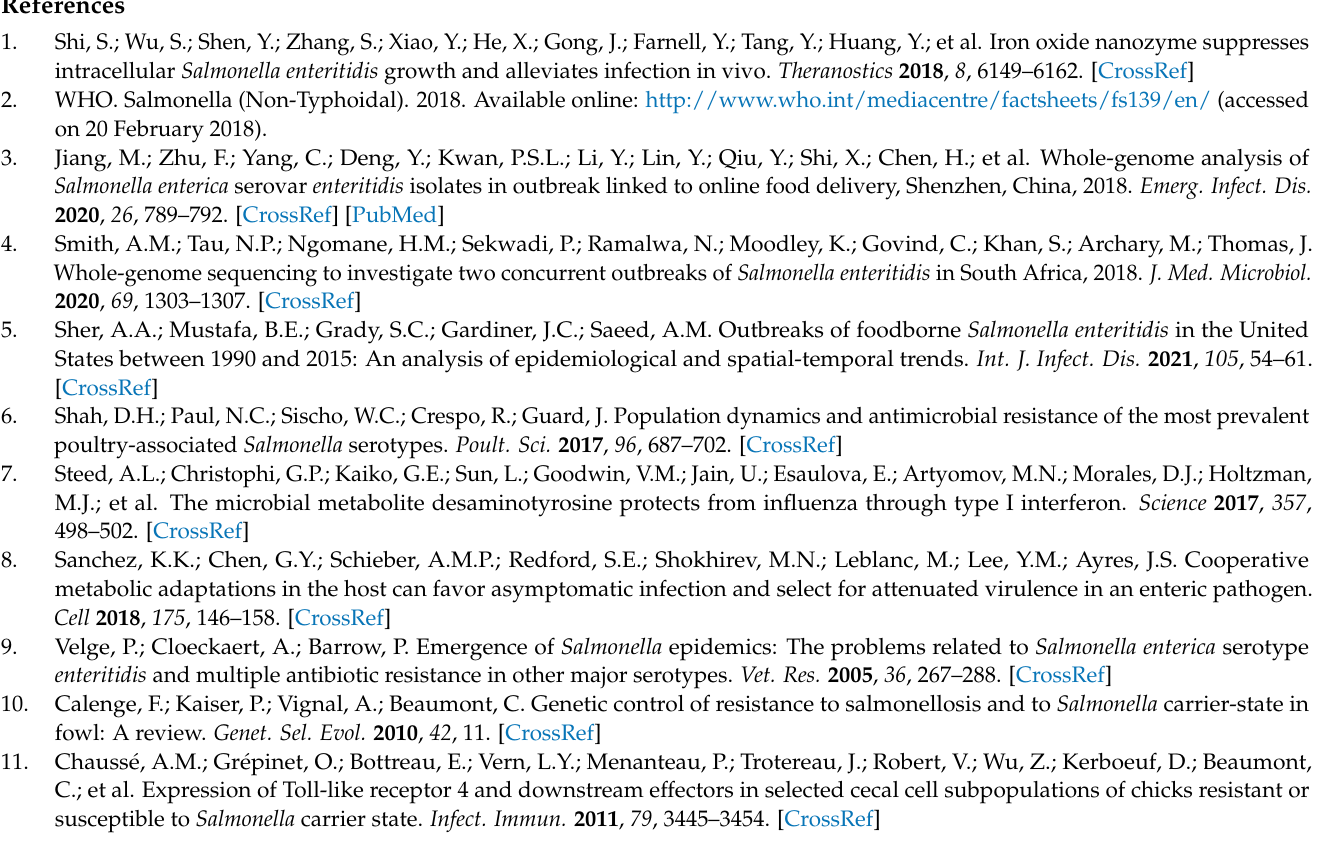
( n = 48), Table S2: Details of sequencing data, Table S3: Alpha diversity analysis of cecal microbiota ( n = 8), Table S4: Beta diversity analysis of cecal microbiota ( n = 8), Figure S1: Rarefaction curves of the observed